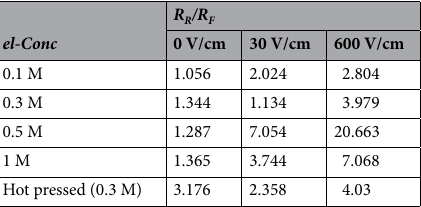
Table 3. Variation of R R / R F with E at different el - Conc